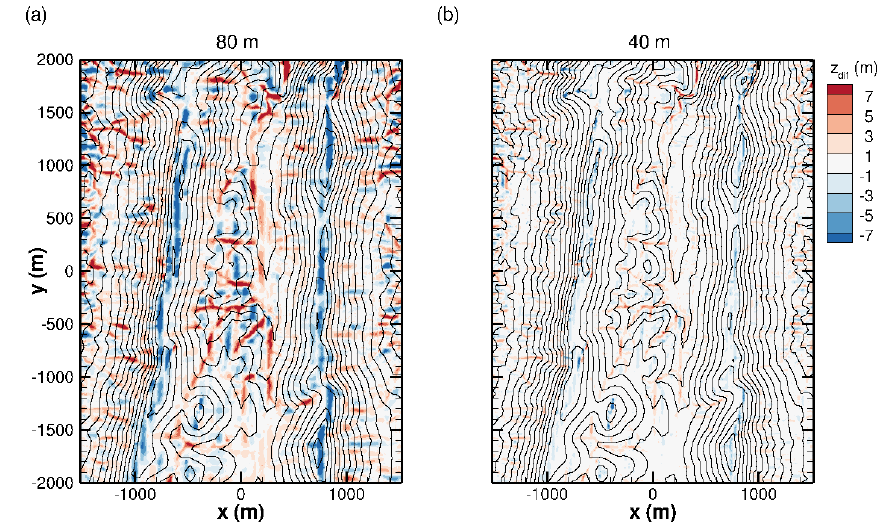
Figure 8. Elevation error of resampled meshes (ALS terrain data) over the AOI surface: (a) 80m mesh, (b) 40m mesh.